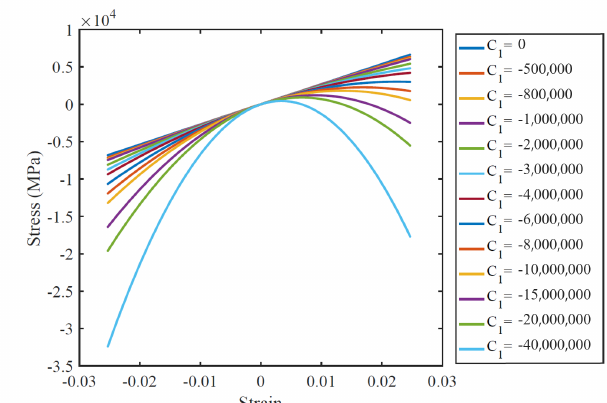
Figure 8. Stress-strain curves under different first order